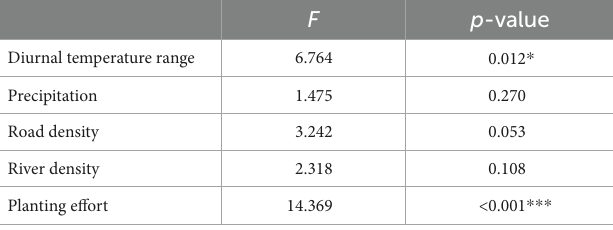
TABLE 1 Results of GAM testing contribution of predictors to change in species richness of selected